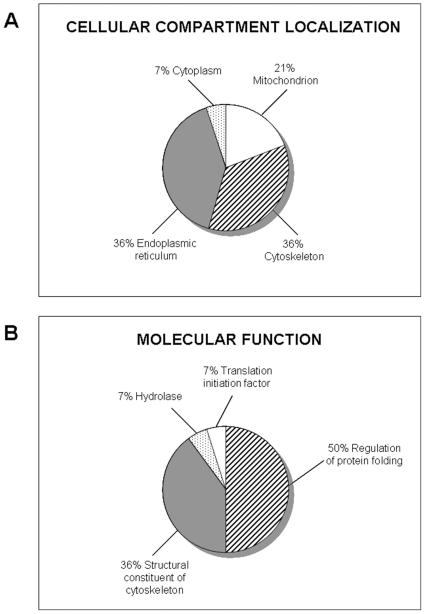
Distribution of identified spots corresponding to proteins differentially phosphorylated following ATRA treatment.Distribution is shown according to proteins cellular compartment localization and their molecular function.